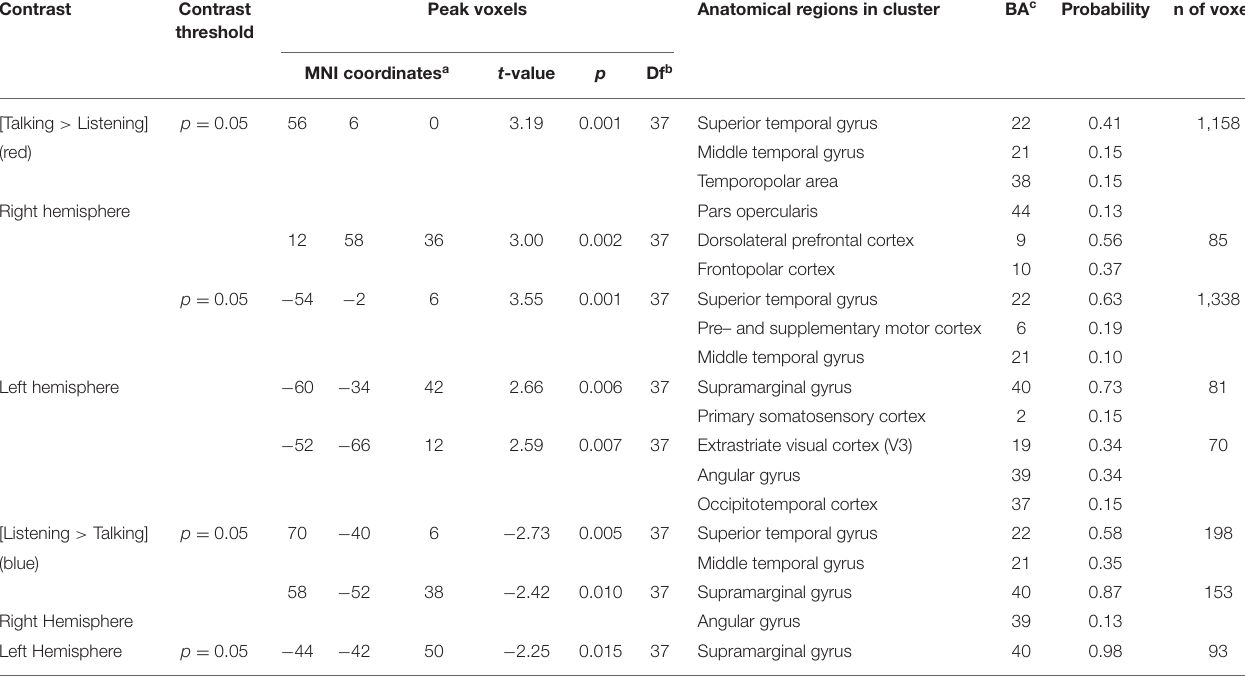
a Coordinates are based on the MNI system and (–) indicates left hemisphere. b df, degrees of freedom. c BA, Brodmann area identified by the TD ICBM MNI atlas (Maldjian et al., 2003) (see Figure 4